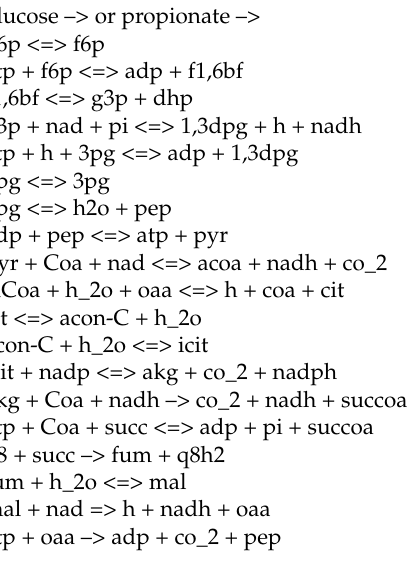
Table A1. List of reactions used for the flux analysis in the metabolic